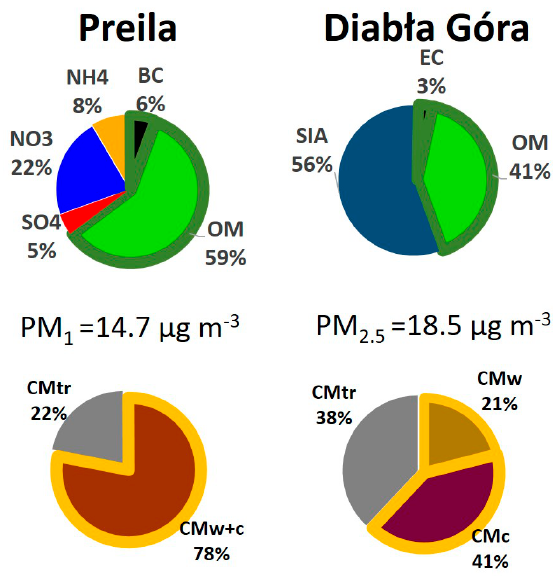
Figure 7. Top: average contribution to PM chemical species. For Diabła G ó ra, Seconday Inorganic Aerosol (SIA) is calculated as the residual between PM 2.5 and carbonaceous matter. Bottom: average source contribution to carbonaceous matter.